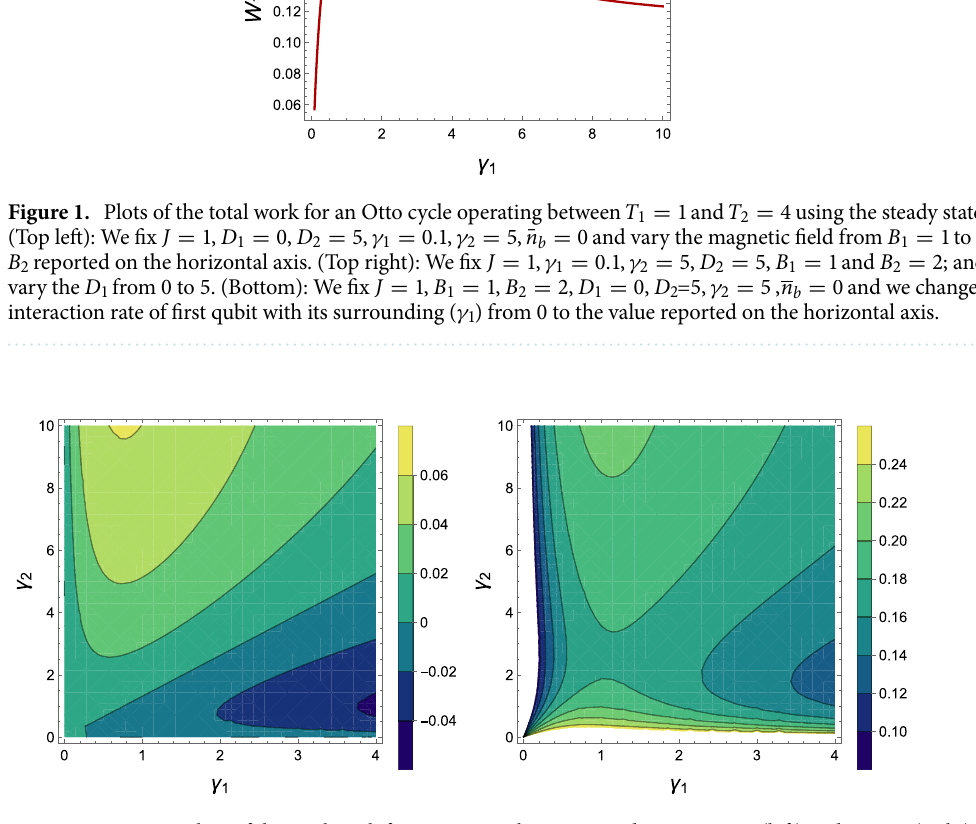
Figure 2. Contour plots of the total work for an Otto cycle corresponding to T 2 = 2 (left) and T 2 = 4 (right) as a function of γ 1 and γ 2 , with J = 1 , B 1 = 1 , B 2 = 2 , T 1 = 1 , ¯ n b = 0 , D 1 = 0 and D 2 = 5 for both